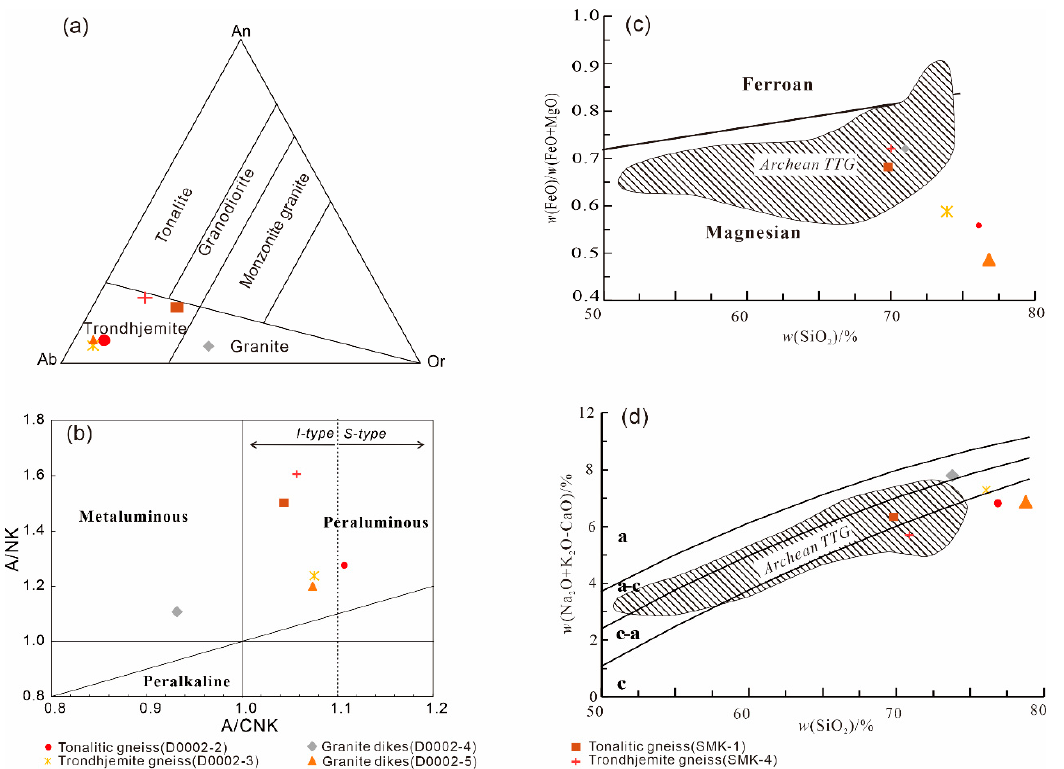
Figure 16. ( a ) The TTG suite of rocks plotted on the CIPW an–ab–or classification diagram (after [34]). An = anorthite, Ab = albite, Or = orthoclase; ( b ) A/NK-A/CNK diagram of granitoids (after [35]); ( c ) FeO t /(FeO t + MgO)–SiO 2 classification diagram (after [36]); and ( d ) granite MALI (Modified alkali-lime index) vs. SiO 2 classification diagram (after [36]).a, alkalic; a-c, alkali-calcic; c-a, calc-alkalic; c, calcic.